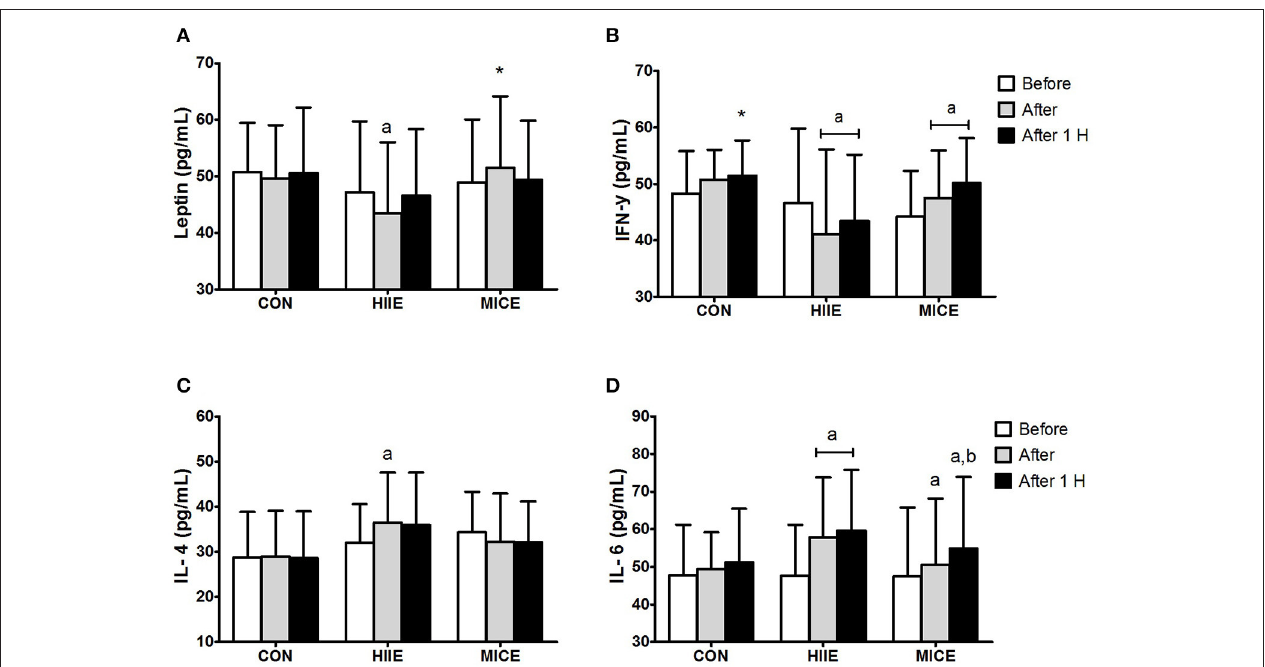
FIGURE 2 | Inflammatory profile before (Before), immediately after (After) and 1h after (After 1H) high intensity interval exercise (HIIE), moderate intensity continuous exercise (MICE), and control (CON) condition. Leptin (A) ; interferon- γ (B) ; interleukin-4 (C) ; interleukin-6 (D) . Values are presented as mean ± sd. a Significant difference compared with before exercise ( P < 0.05). b Significant difference compared with before exercise ( P < 0.05). *Significant difference compared with HIIE ( P < 0.05).